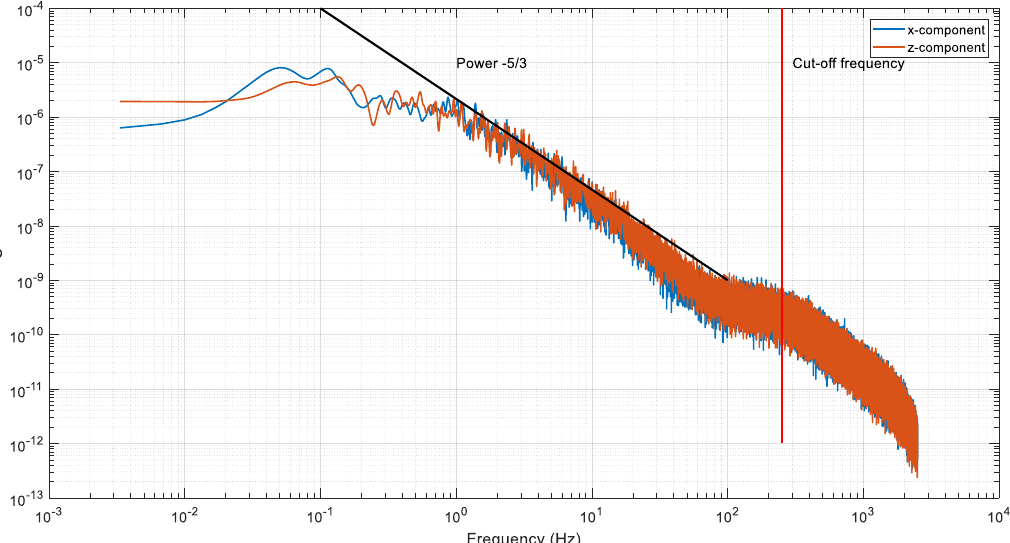
Figure 11. Power spectrum of the two velocity components of the top left measurement point in Figure 10b,c. The spectrum contains the expected power −5/3 dependency on the frequency. The cut-off frequency originates from the analogue filter used in the measurement setup to cancel out high-frequency noise.